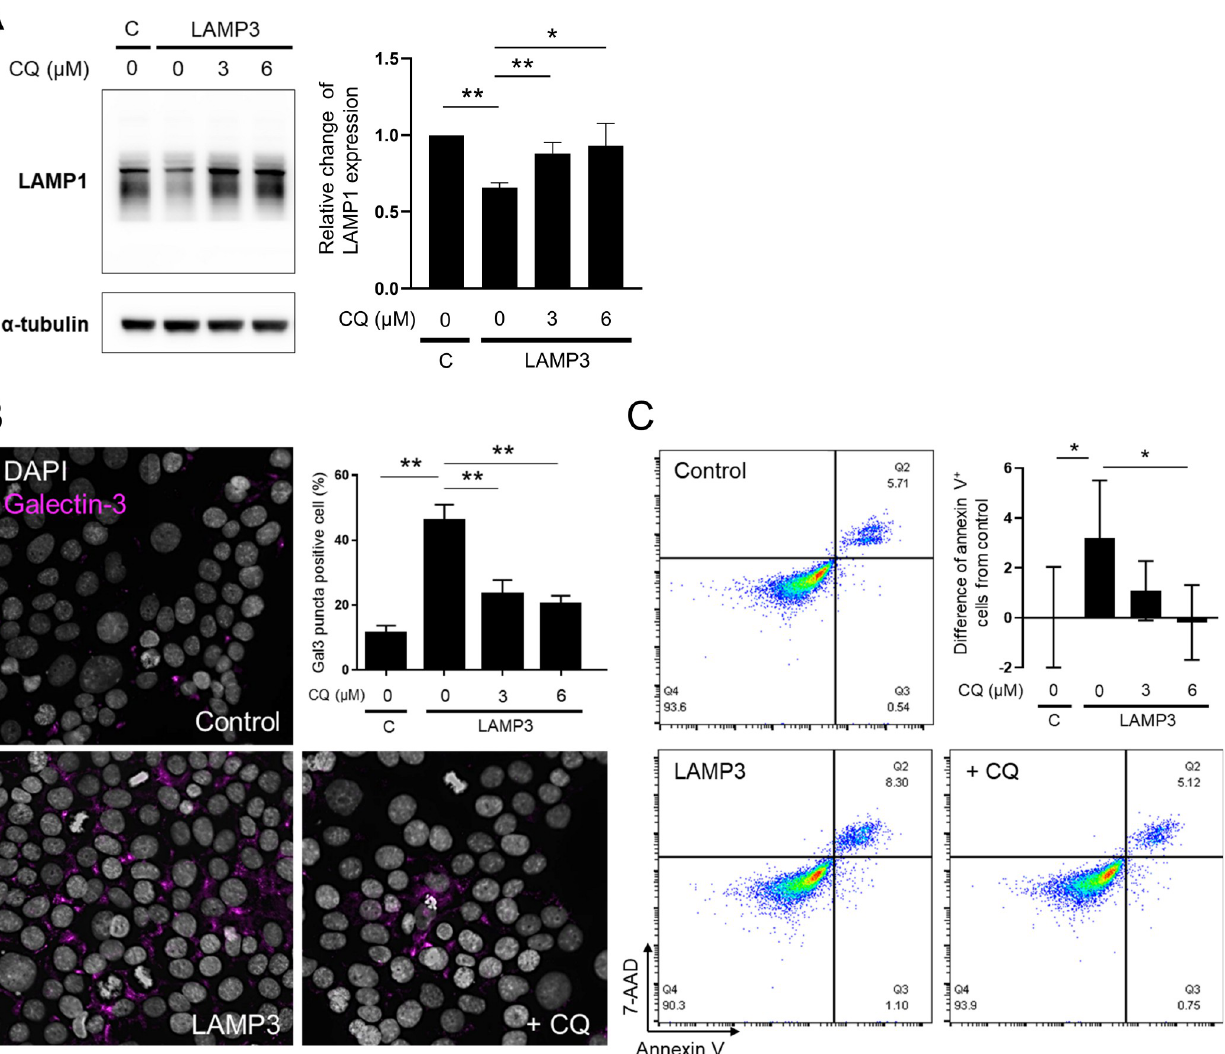
Fig 2. Chloroquine prevents LAMP3-induced apoptotic cell death in vitro . Stably LAMP3-overexpressing A253 cells were treated with chloroquine (CQ) for 24 hours at increasing concentrations. ( A ) Representative Western blots showing expression of LAMP1 and α -tubulin (control). Bar chart shows relative change of LAMP1 expression normalized by α -tubulin expression compared to control A253 cells ( n = 3). C: control A253 cells. ( B ) Representative immunofluorescent images showing staining for galectin-3 (magenta) (40 × magnification). Bar chart shows percentage of galectin-3 (Gal3) puncta-positive cells ( n = 3). ( C ) Number of apoptotic cells was determined by flow cytometry using APC Annexin V/7-AAD. Bar chart shows percentage of difference in Annexin V-positive cells from control ( n = 5). Values shown are mean ± SD. � P < 0.05, �� P < 0.01, N.S. = not significant (Student’s t -tests with Dunnett’s